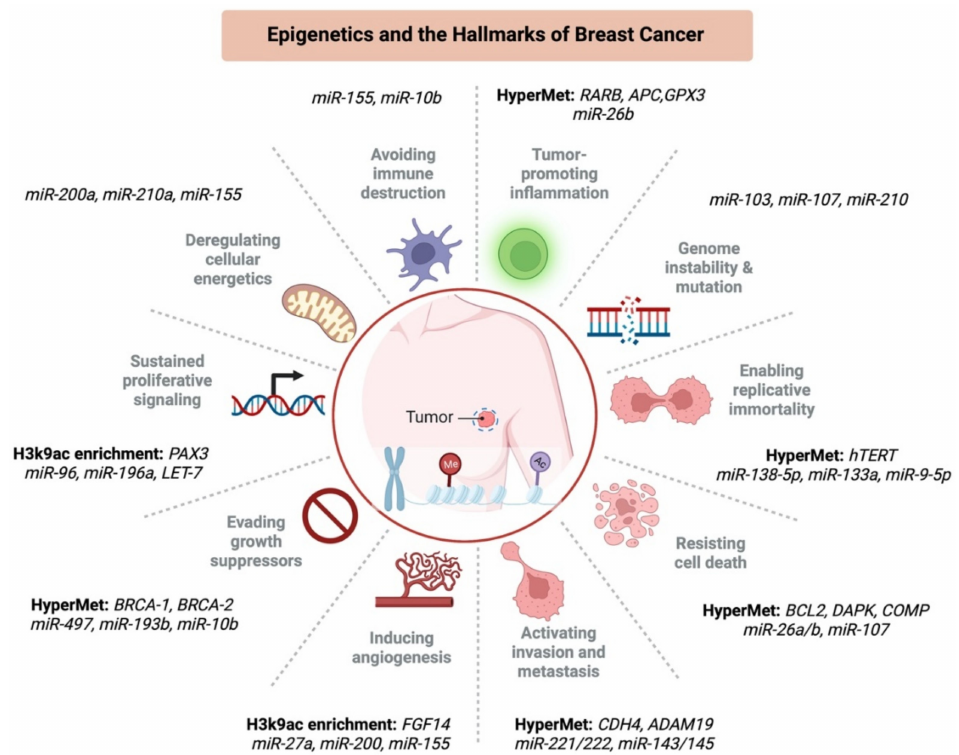
Figure 2. A collection of breast cancer hallmarks that characterizes the breast cancer phenotype with the central role for epigenetic modifications shaping the tumor outcome. Disruption of epigenetic processes modulates signaling pathways promoting breast tumorigenesis. Epigenetic alterations which are attributed to specific breast cancer hallmarks are depicted. (HyperMet; promoter hyperme- thylation) [6,34–37]. Figure created using BioRENDER.com. Accessed on 25 July